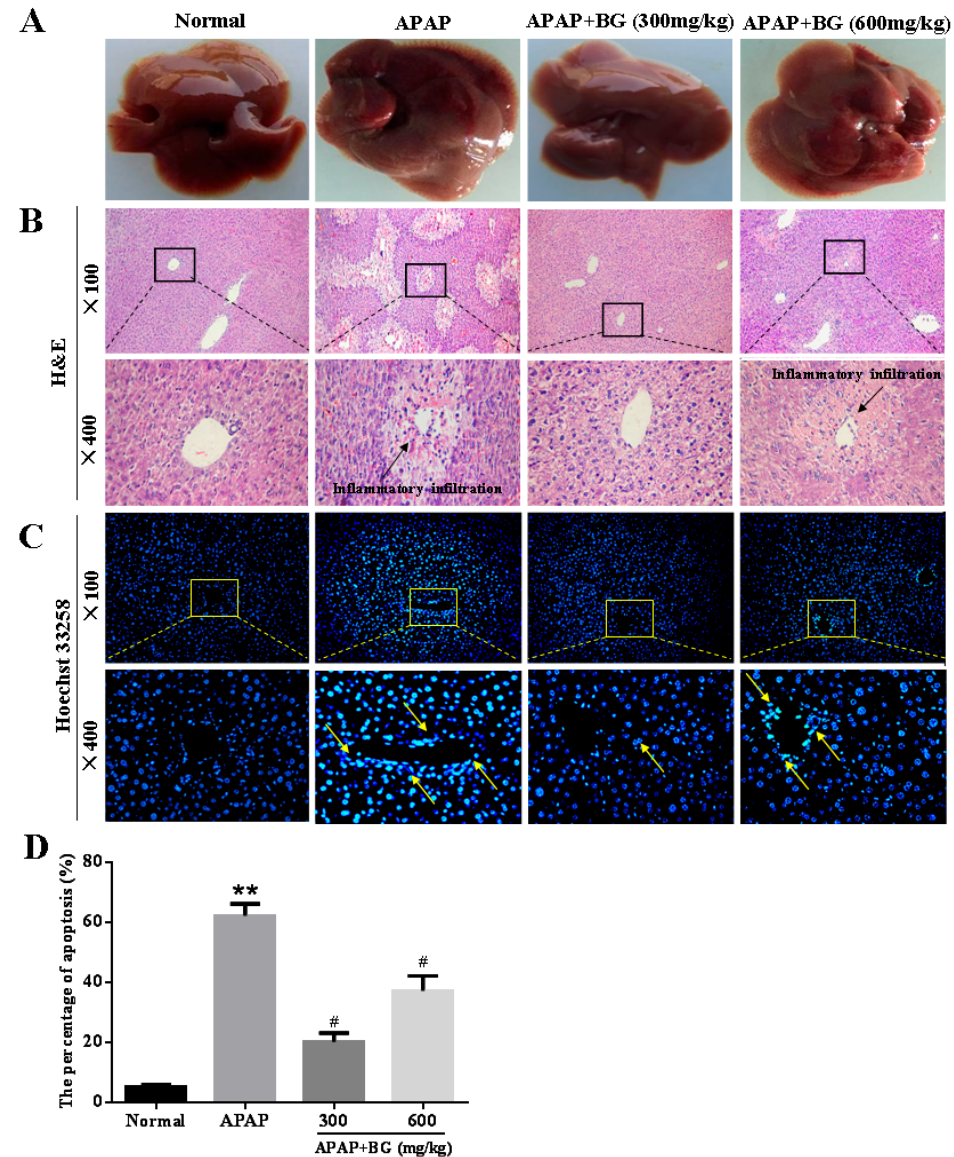
Figure 4. Histological examination of morphological changes in liver tissues. Pathological change of livers ( A ); and liver tissues stained with H&E ( B ); and Hoechst 33258 ( C ); and the percentage of apoptosis ( D ). Arrows show necrotic and injured cells. All data were expressed as mean ± S.D, n = 8. ** p < 0.01 vs. normal group; # p < 0.05, vs. APAP group.